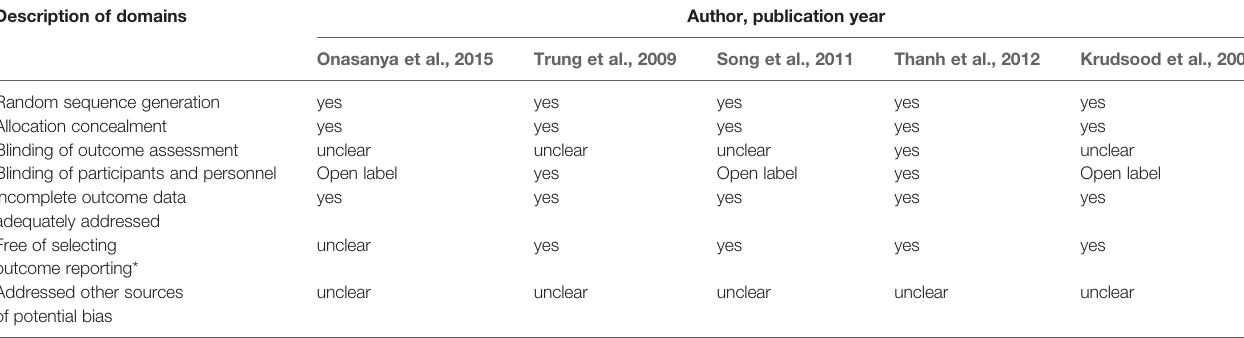
TABLE 2 | The risk of bias of the included